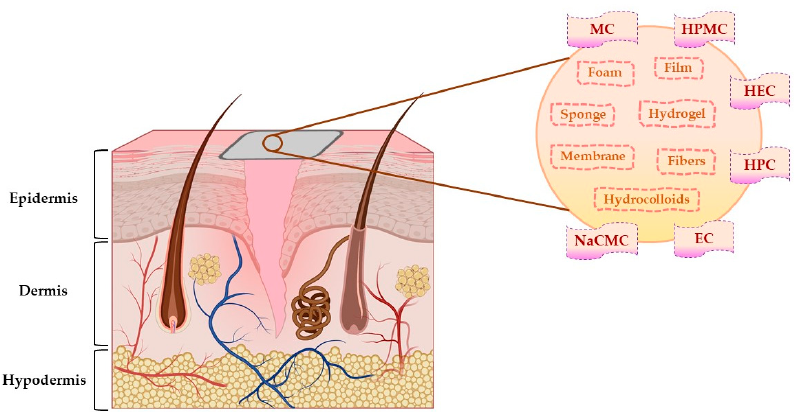
Figure 6. The representation of cellulose derivatives-based wound dressing on an open wound. This illustration has been created with BioRender.com, Inkscape, and PowerPoint.